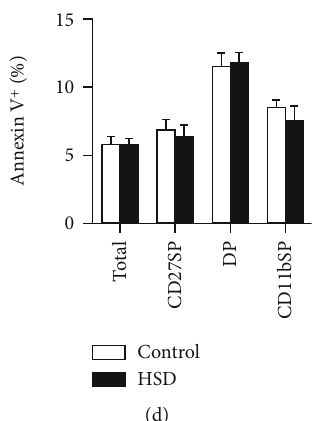
Figure 5: HSD decreases NK cell proliferation but does not disturb apoptosis. Representative fl ow cytometry pro fi les of Ki67 + splenic NK cells from control and HSD-fed mice during di ff erent developmental stages (a). The percentage of Ki67 + NK cells (b). Representative fl ow cytometry pro fi les of annexin V + cells from control and HSD-fed mice during di ff erent developmental stages (c). The percentage of annexin V + NK cells (d). All the data represent at least three independent experiments. Data are shown as the means ± SEM . Unpaired Student ’ s t -tests (two-tailed) were performed using the Prism software. A P value of < 0.05 was considered signi fi cant. ∗ P < 0 : 05 , ∗∗ P < 0 : 01